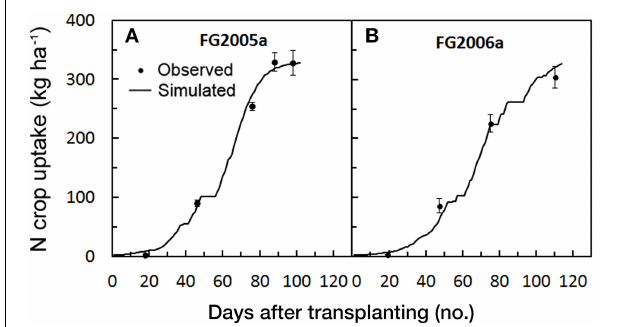
FIGURE 3 | Simulated and observed N crop uptake during the two tomato cycles in Foggia [FG2005a (A) and FG2006a (B)], used for calibrating GesCoN . Mean Standard errors, when larger than the symbol, are represented by vertical bars.